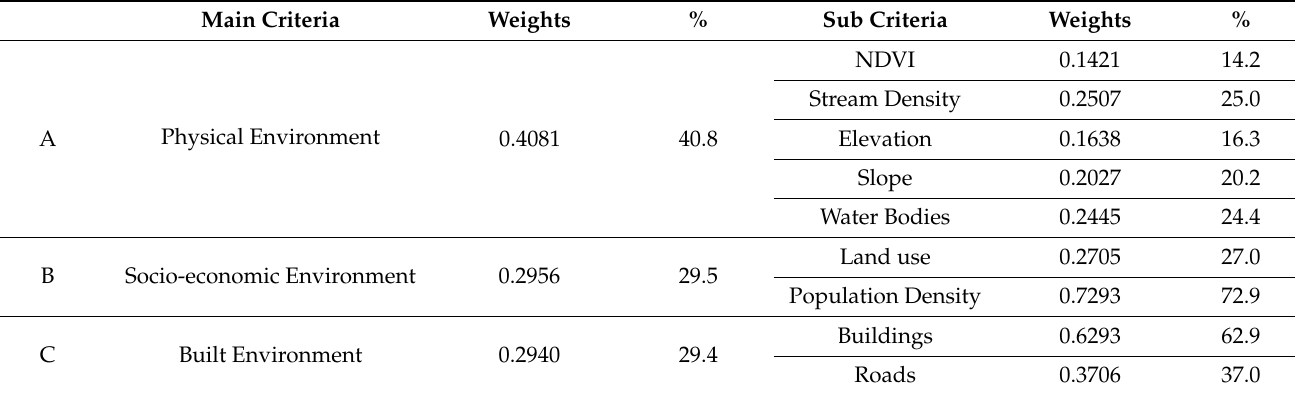
Table 6. Weights assigned for each major and minor criterion of the